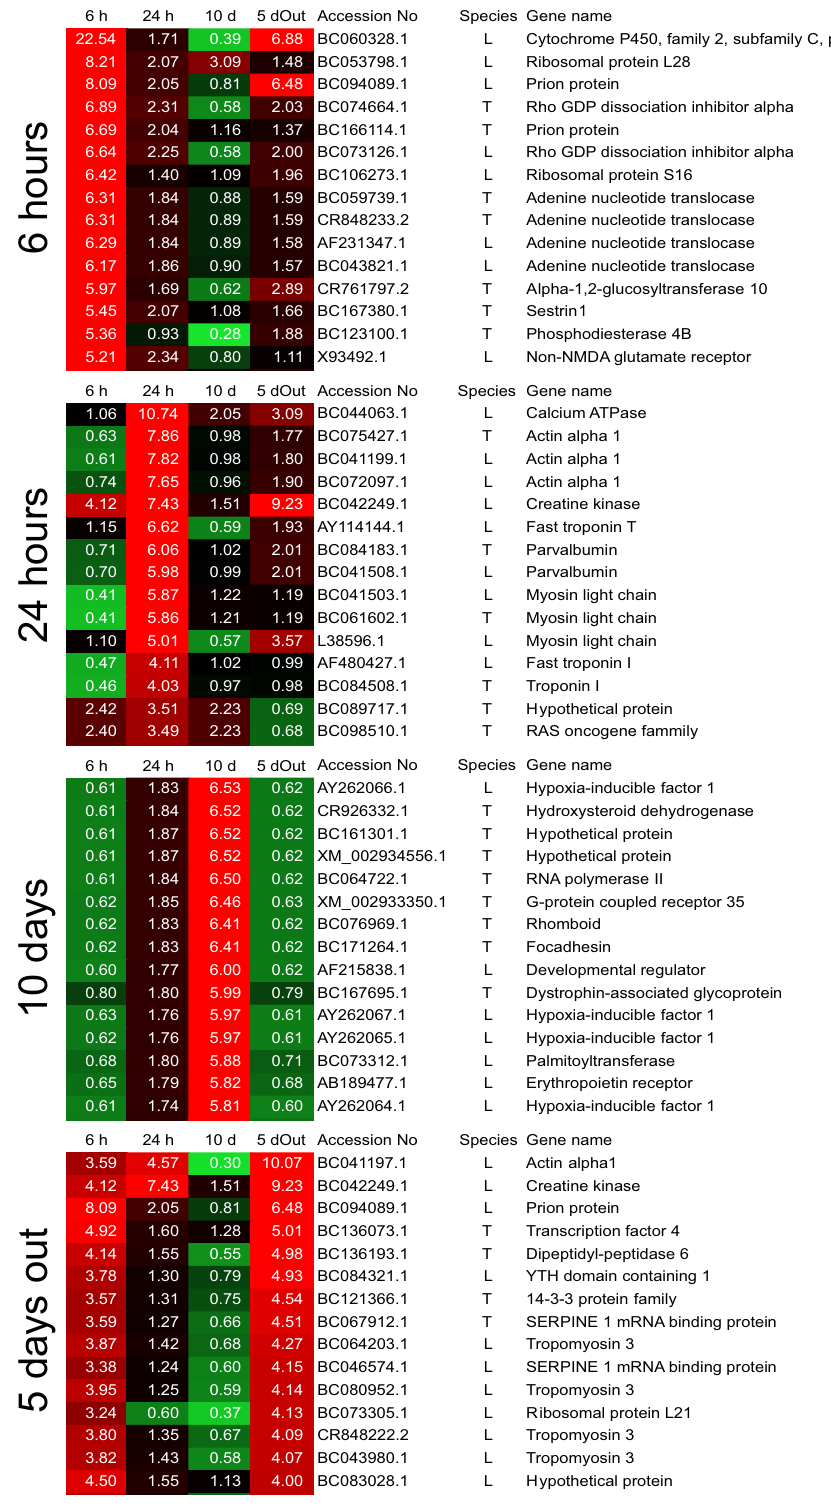
Figure 2. Heat map using 3 ′ -tag digital gene expression profiles from Xenopus laevis whole brain tissues. Gene expression profiling was performed using the top 15 genes that were expressed by over 1,000 tags from each of the experimental groups described in Fig. 1. The numbers on the heat map indicate the total number of tags expressed for each gene in the experimental and control groups. Accession No: gene number obtained from the NCBI database. Species: “L” indicates Xenopus laevis , and “T” indicates Xenopus tropicalis . The heat map colors and numbers indicate the fold changes in gene expression compared with that of the